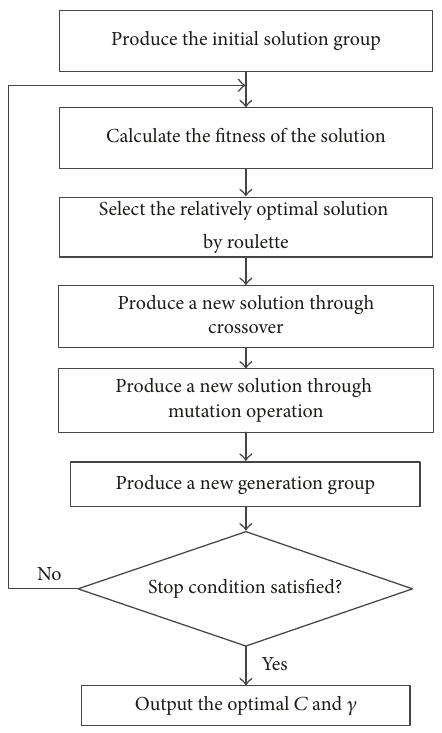
Figure 3: Flow chart of the Genetic Algorithm.